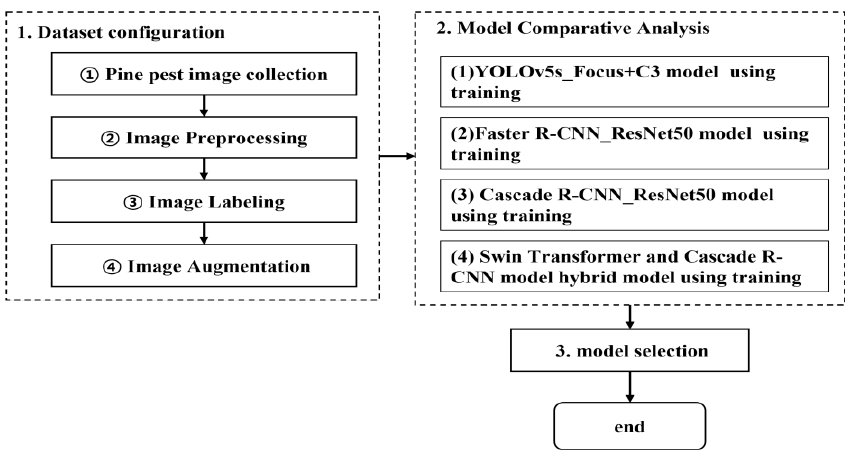
Figure 2. Process for the comparative analysis of applied artificial intelligence.